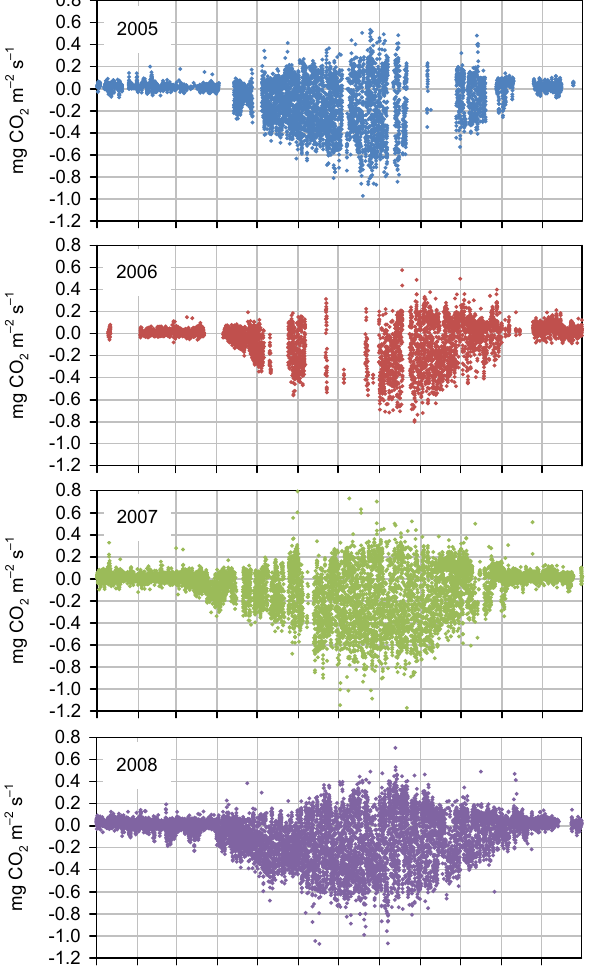
Figure 3. Quality-controlled half-hourly NEE measured with the eddy covariance method at Kalevansuo peatland in 2005–2008.